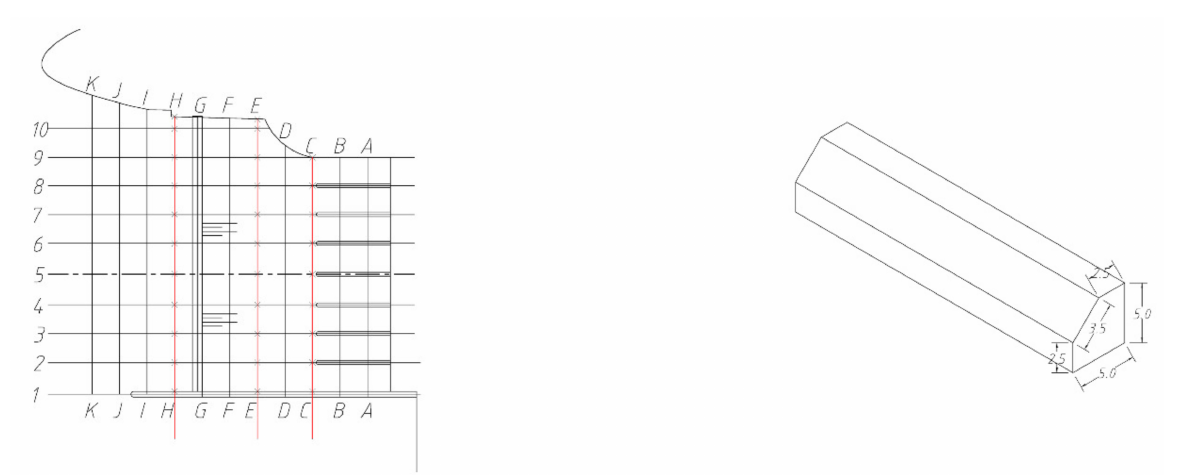
Figure 9. Plan 3 (unit: cm).